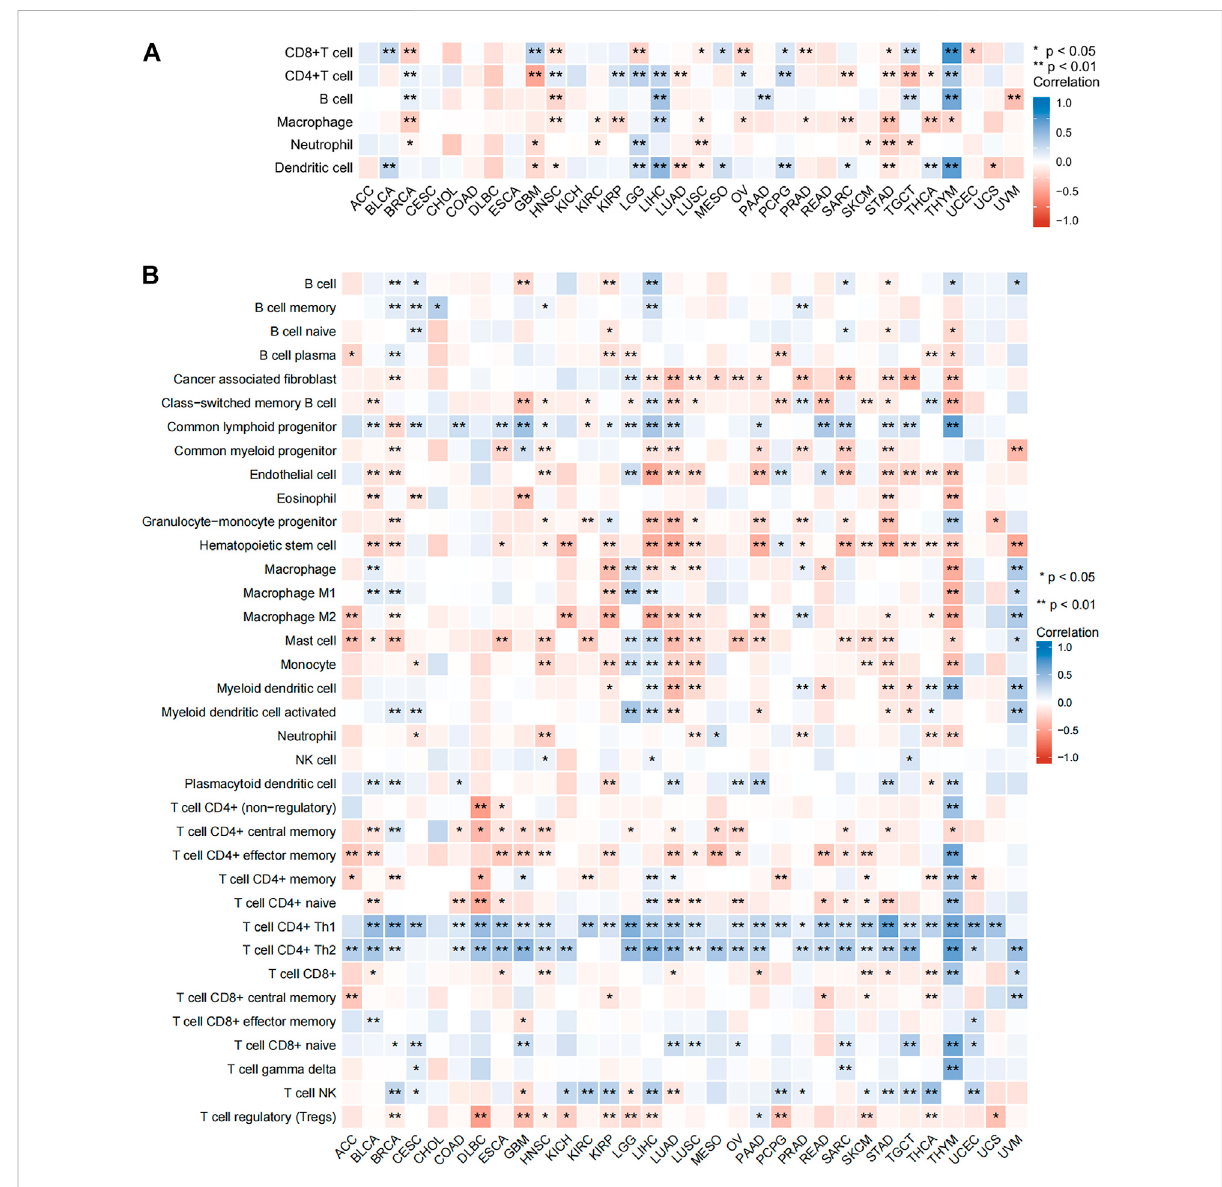
FIGURE 11 Relationship between SNRPB and immune cell in fi ltration. (A) . Relationship between SNRPB and immune cell in fi ltration based on the TIMER algorithm. (B) . Relationship between SNRPB and the in fi ltration of immune cell subtypes based on the xCell